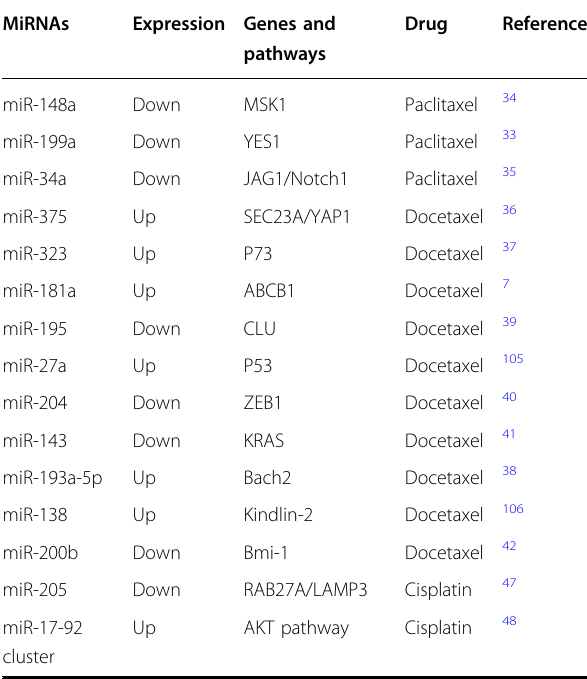
Table 3 MiRNA and chemoresistance in prostate cancer.